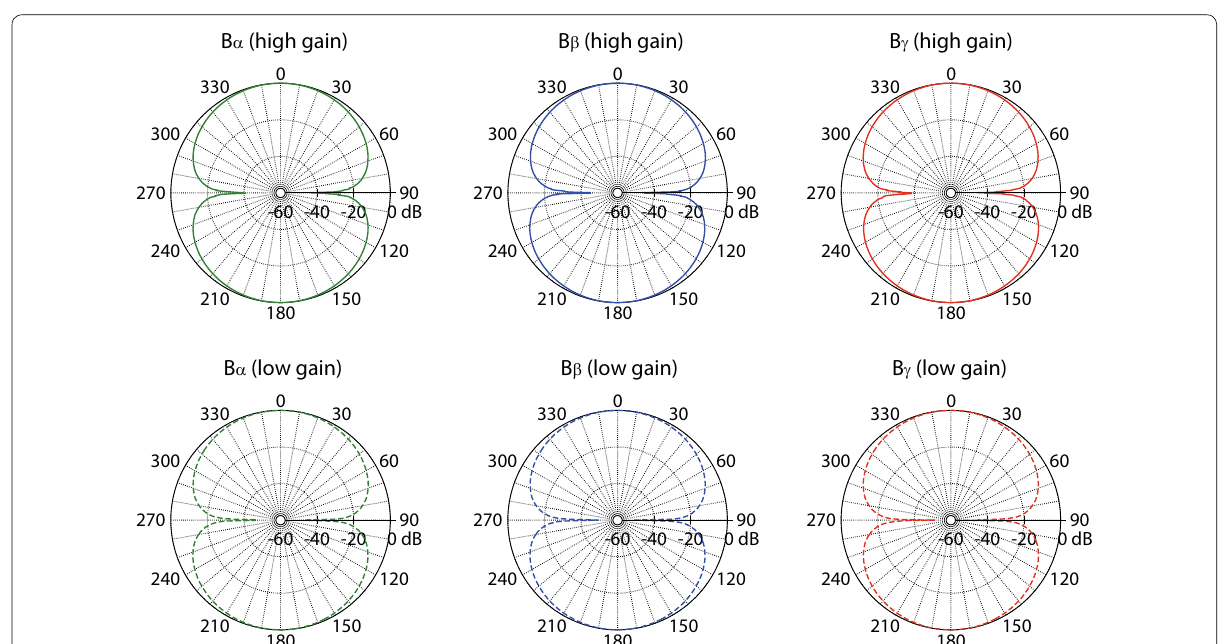
40 dB, which is equivalent to an angle error less than 1 −